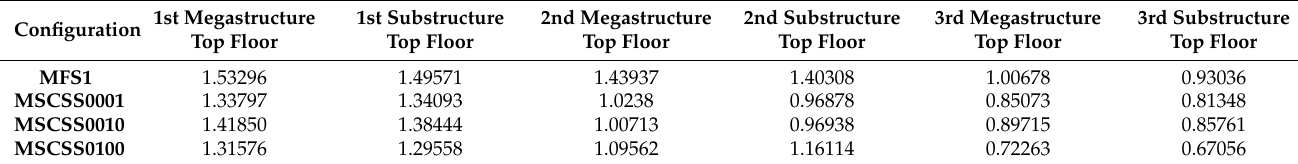
Table 9. The acceleration response at a critical point of the investigated configurations under the TAFT wave (m s − 2